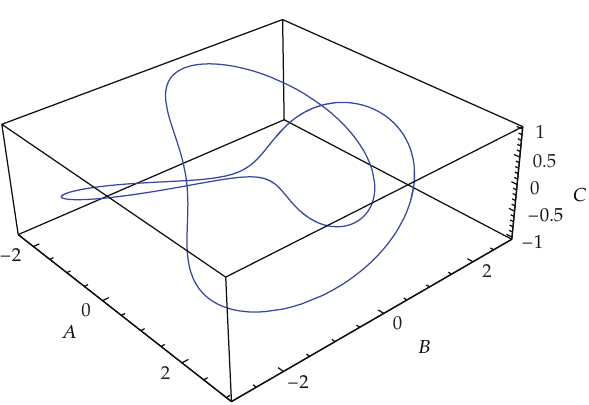
Figure 1: The trefoil knot for (cid:2) 3.3 (cid:3) , where A 0 (cid:6) B 0 (cid:6) C 0 (cid:6)